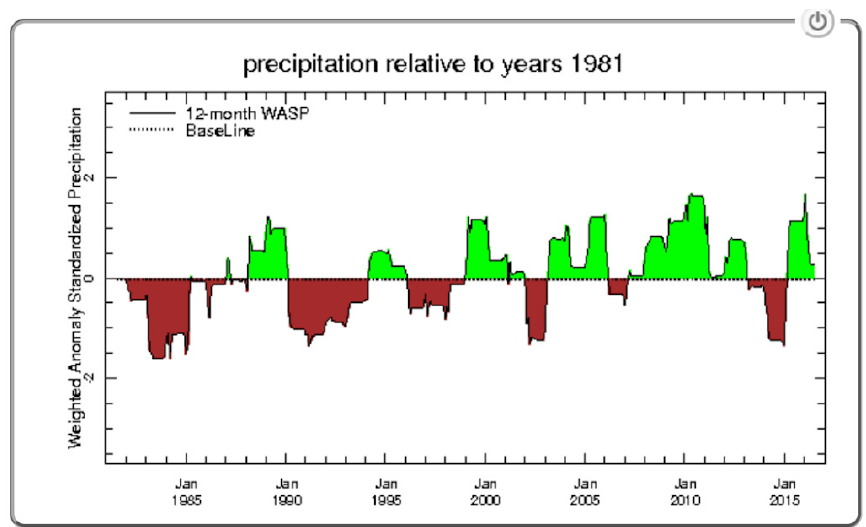
Figure 12. Country Average Weighted Anomaly Standardization Precipitation (WASP) for Senegal.